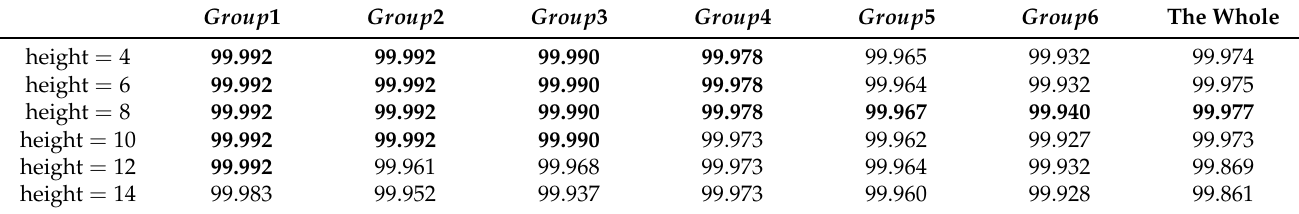
Table 4. The detection performance of the proposed method (WMD) with respect to different height. Group 1 Group 2 Group